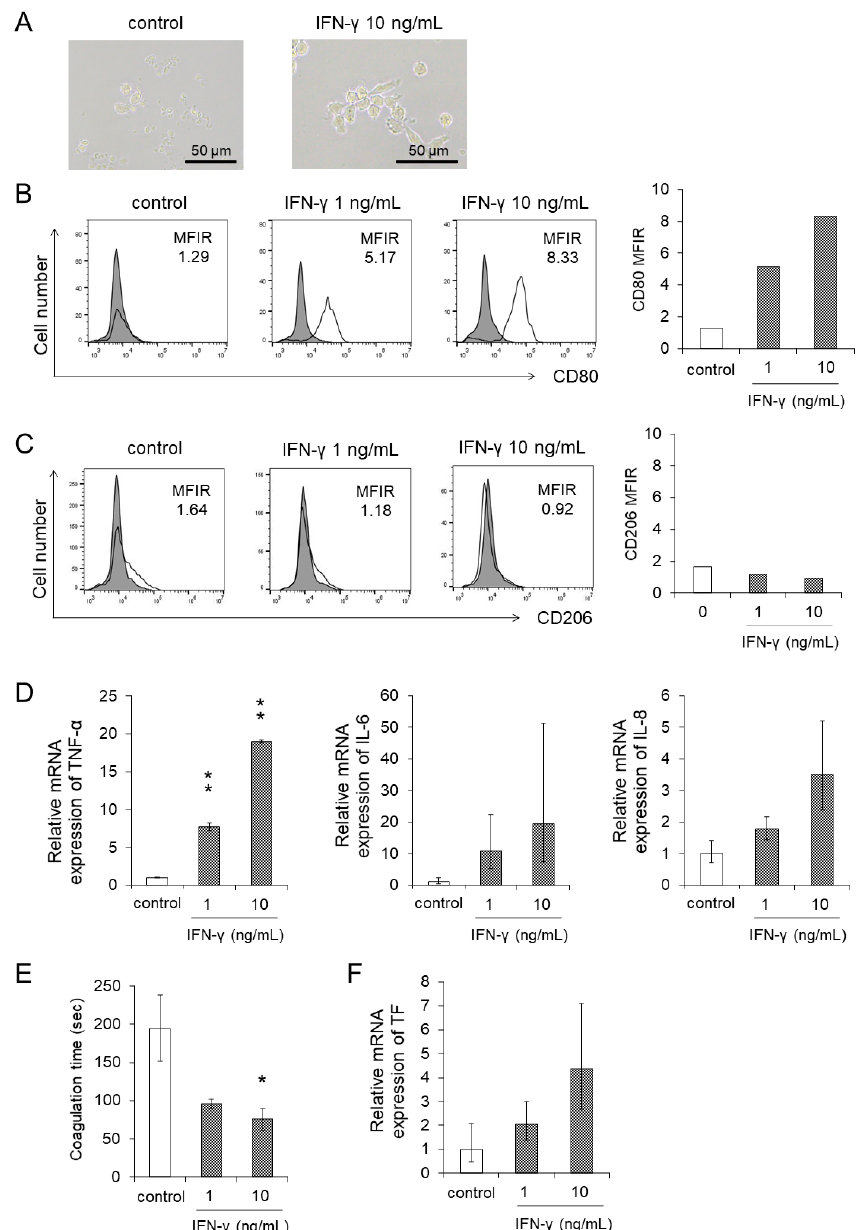
Figure 5. Differentiation and procoagulant activity were promoted by the stimulation of IFN- γ . Human monocytes were treated with recombinant IFN- γ for 24 h. The same amount of culture media of EBV-positive T- or NK-cell lines was added as an untreated control. After the treatment, the target cells were subjected to each assay. ( A ) The representative morphology was pictured using an optical microscope. ( B , C ) The CD80 ( B ) and CD206 ( C ) expression on human monocytes was determined by flow cytometry. The representative figure is shown on the left panel indicating CD80 and CD206 (open histogram) or isotype-matched control (gray, shaded histogram). The mean fluorescent intensity of CD80 and CD206 was normalized by that of isotype-matched control and expressed as MFIR. ( D , F ) The mRNA expression of TNF- α , IL-6 , IL-8 ( D ), and TF ( F ) in human monocytes was analyzed by qRT-PCR assay ( n = 3). The expression was normalized to GAPDH mRNA. ( E ) The PCA on human monocytes was measured using the normal plasma-based recalcification time ( n = 3). Shortening of the coagulation time indicates increased PCA. The data are shown as the mean ± SD of three independent healthy donors. Statistical analyses are assessed and indicated as * p < 0.05 and ** p < 0.01 compared to the